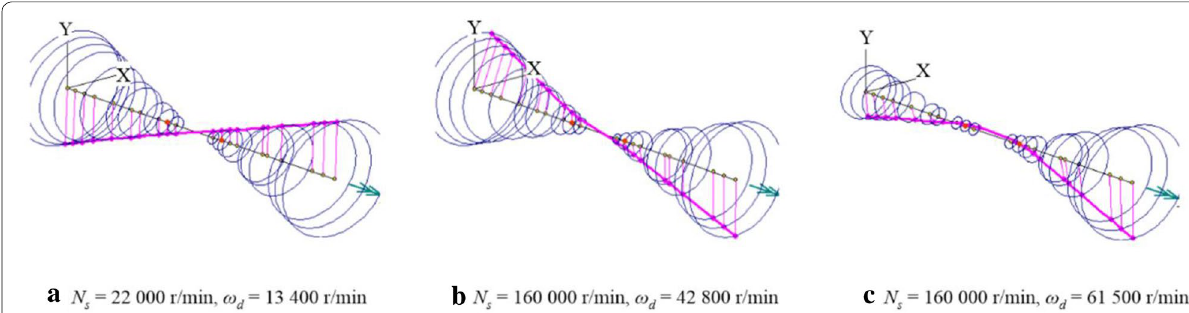
Figure 5 Predicted modes of instability for TC rotor with linearized